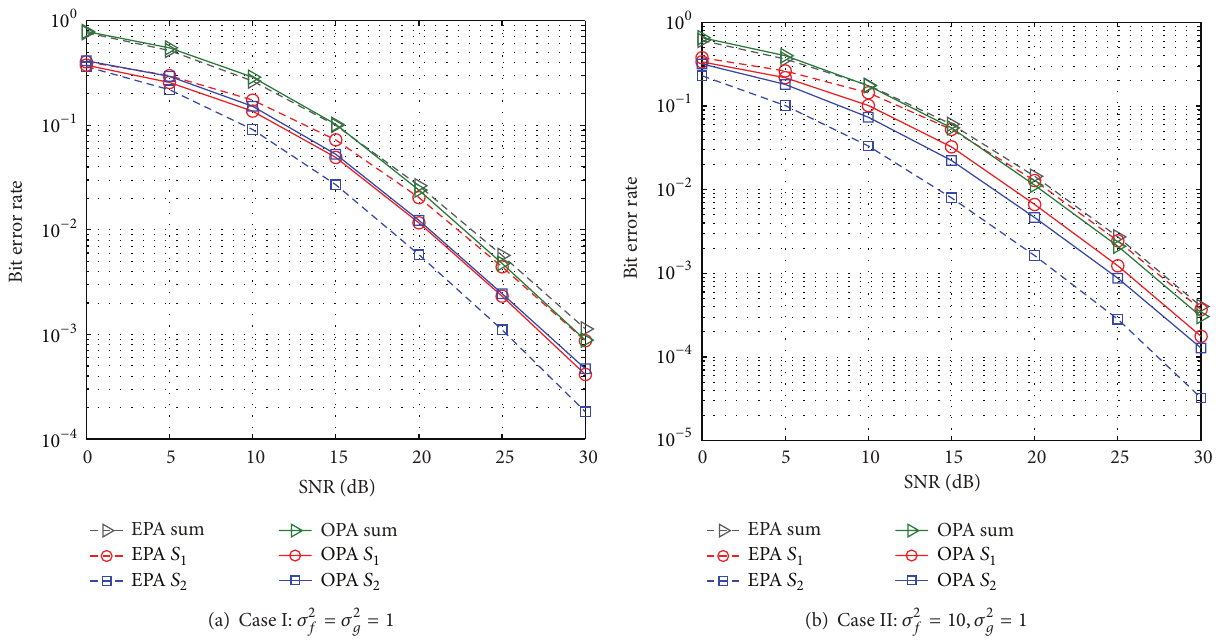
Figure 4: BER performance of the proposed detection scheme with optimum power